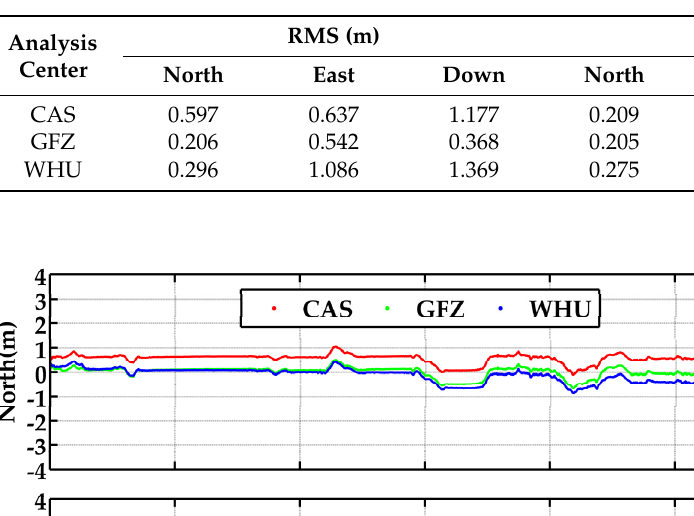
Figure 9. Distribution of position differences of G + B SF-PPP/INS tight integration in the horizontal direction ( left ) and vertical direction ( right ) using real-time products from CAS, GFZ, and WHU. Table 5. Position RMS and STD in the three directions of SF-PPP/INS tight integration using real- time products from CAS, GFZ, and WHU. Analysis Center